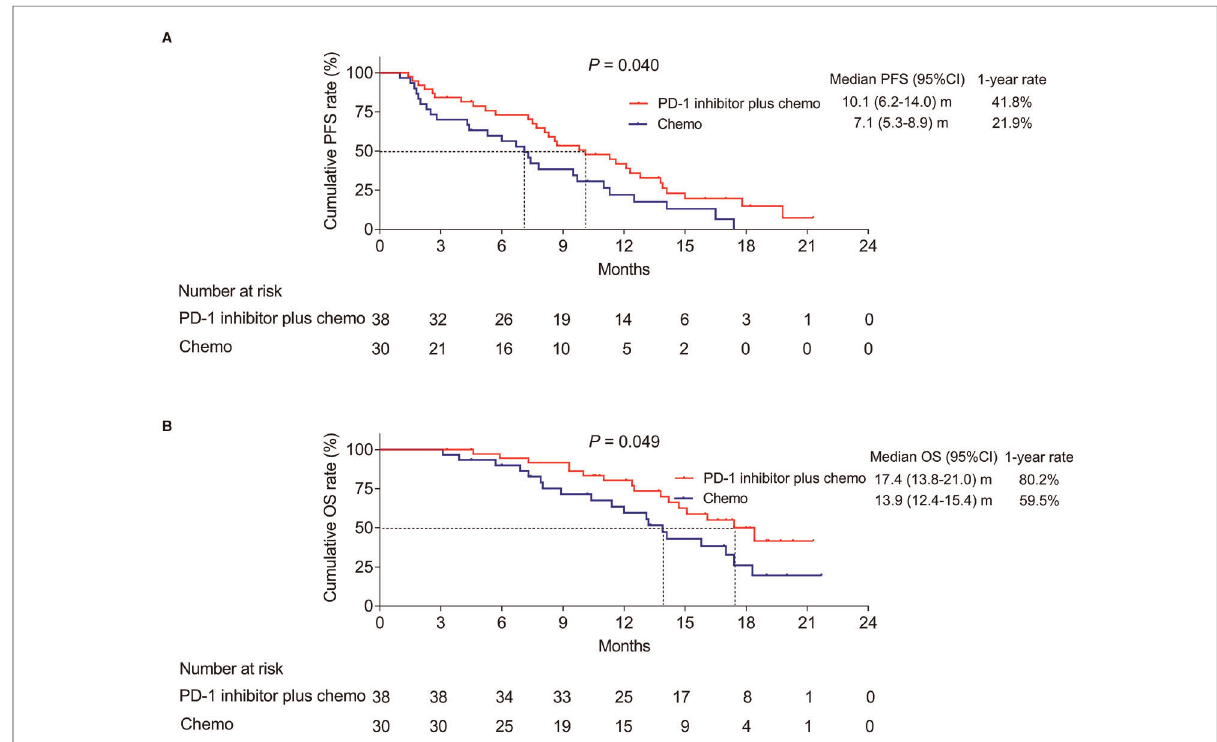
FIGURE 1 Survival pro fi le. PFS ( A ) and OS ( B ) of advanced driver-gene-negative nonsquamous NSCLC patients adopting PD-1 inhibitor plus chemotherapy and chemotherapy alone.